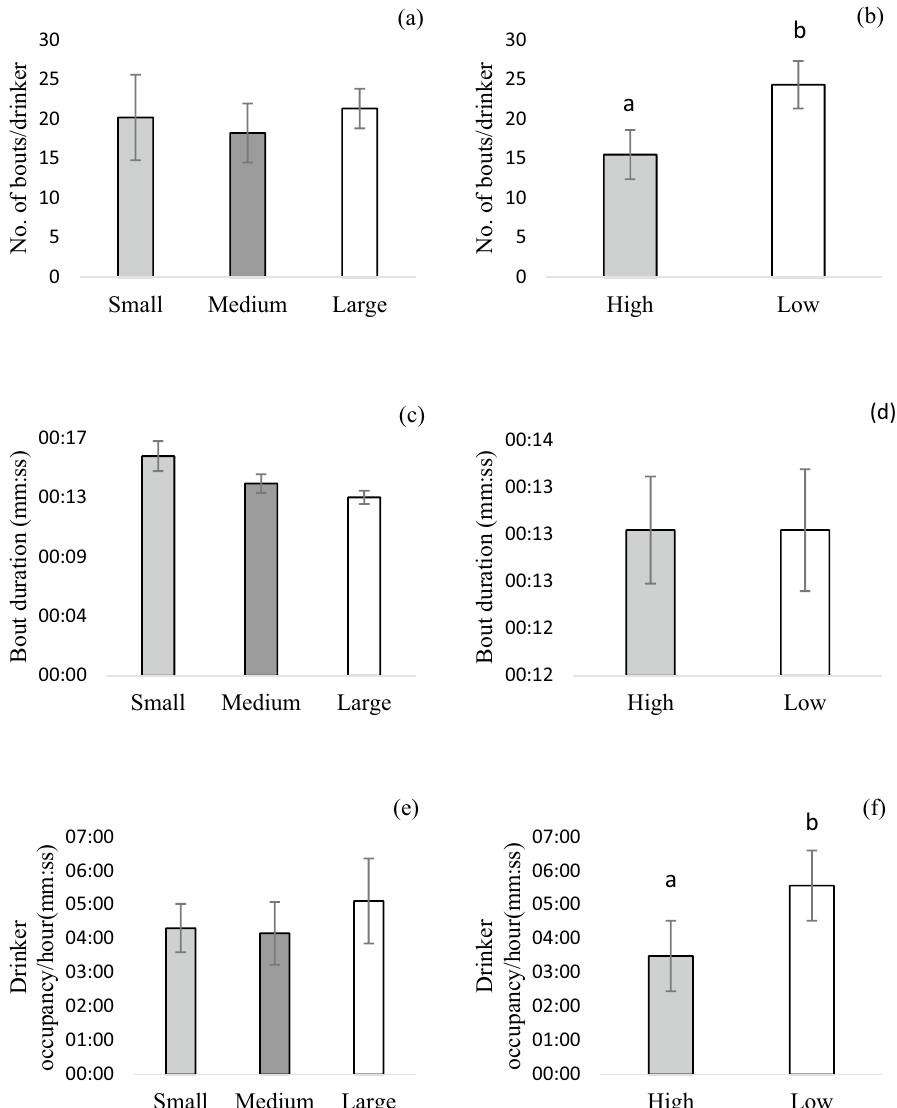
Figure 3. Effect of group size and enrichment on drinking behavior (LSmeans ± SE) ( a , b ) number of bouts per drinker ( c , d ) duration of each bout ( e , f ) occupancy of each drinker per hour. Group size: Large (48 pigs/pen), Medium (24 pigs/pen), Small (12 pigs/pen), Enrichment: Low (Wood + Hanging toy), High (Wood + Hanging toy + Grass) abc Different letters denote significant differences picked up by Tukey–Kramer test ( p <